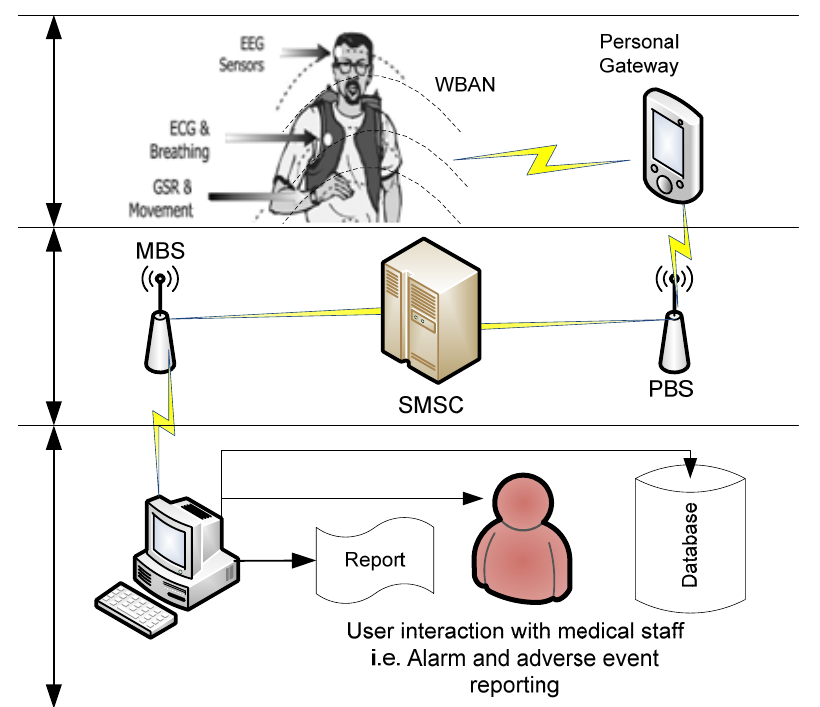
Figure 1. A medical telemetry system architecture for physiological data